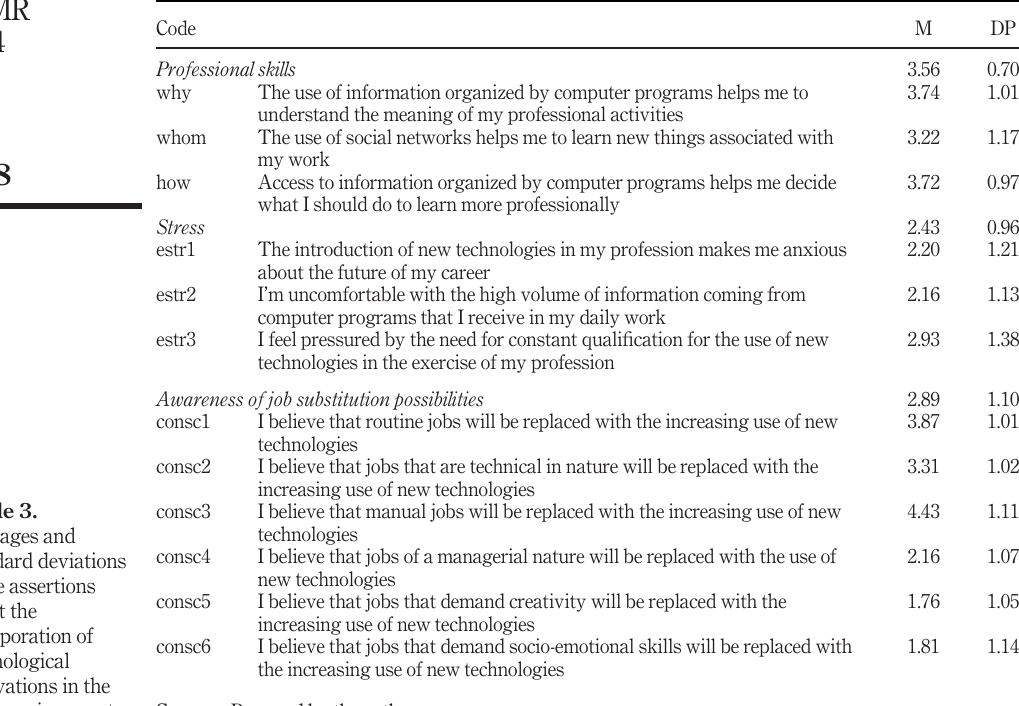
Table 3. Averages and standard deviations of the assertions about the incorporation